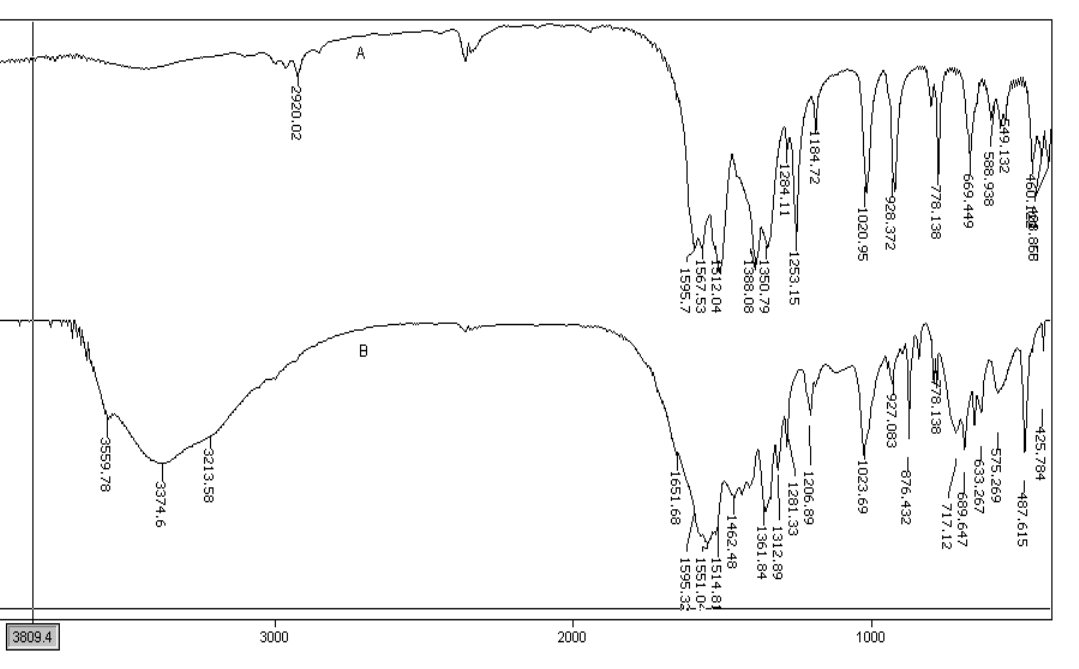
Figure 2. Comparative FTIR spectra: A) the complex of Mn(III)-acetylacetone B) the complex of Mn(III)-diacetylacetonehydroxylaminmaleate.